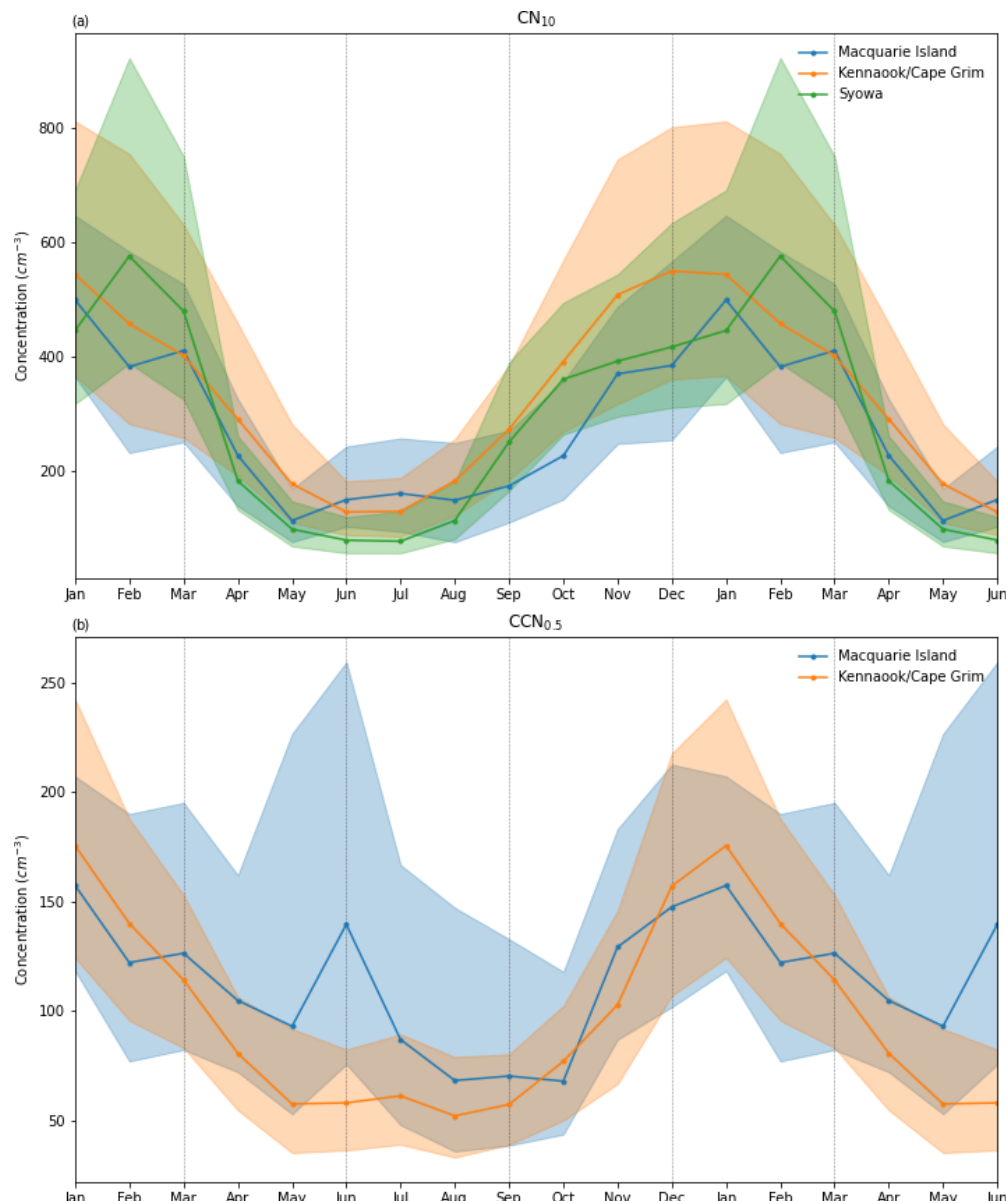
Figure A1. Annual cycles of CN 10 (a) and CCN 0 . 5 (b) at Macquarie Island (blue), Kennaook / Cape Grim (orange) and Syowa (green). The first 6 months are repeated to show the seasonal cycle over 18 months to enable visibility of both summer maxima and winter